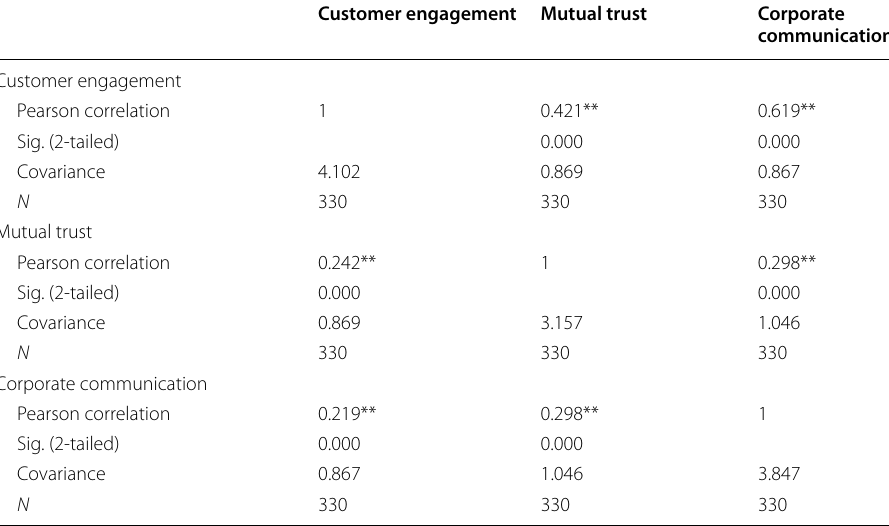
**Correlation is significant at the 0.01 level (2-tailed)